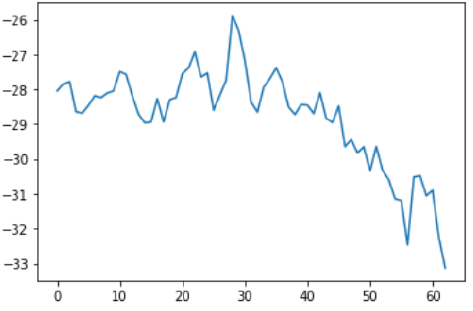
Figure 18. Magnetometer y -axis noise (CCIS/KSU).